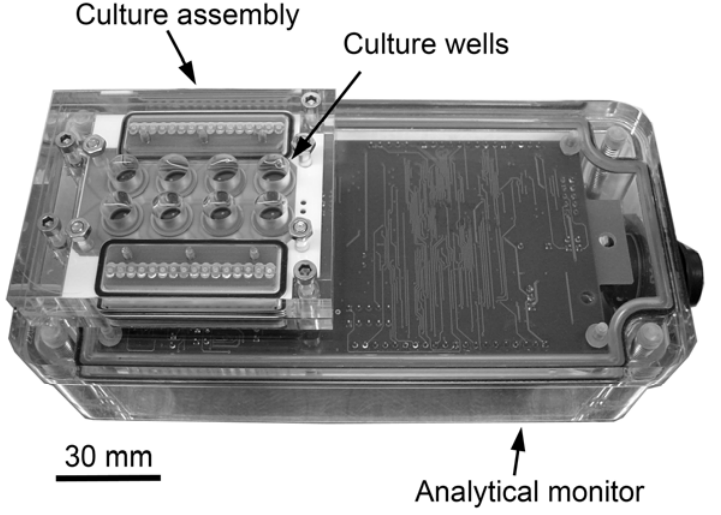
Figure 1. Oncoprobe instrument: Analytical monitor and 8-well cell culture